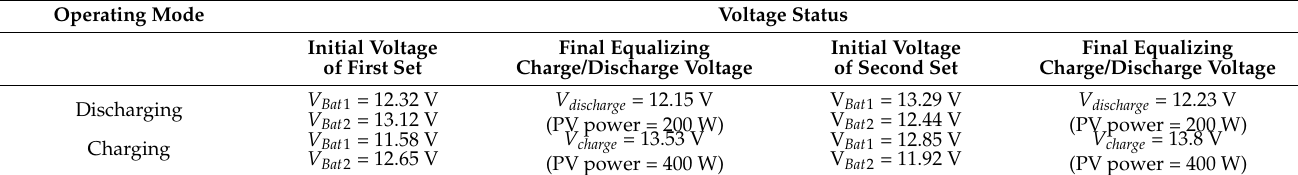
Table 3. Initial voltage and final voltage after reaching equalizing charge/discharge of each battery set under different PVMA output power.